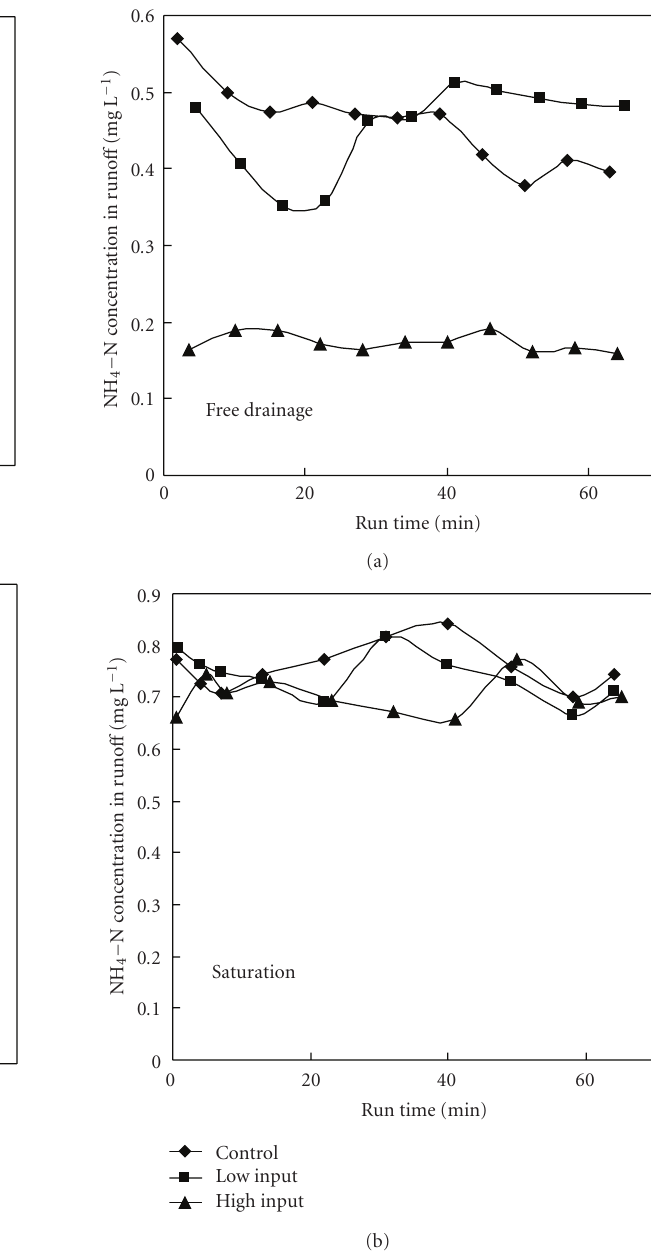
Figure 3: The NH 4 –N concentration in runo ff under di ff erent hydraulic